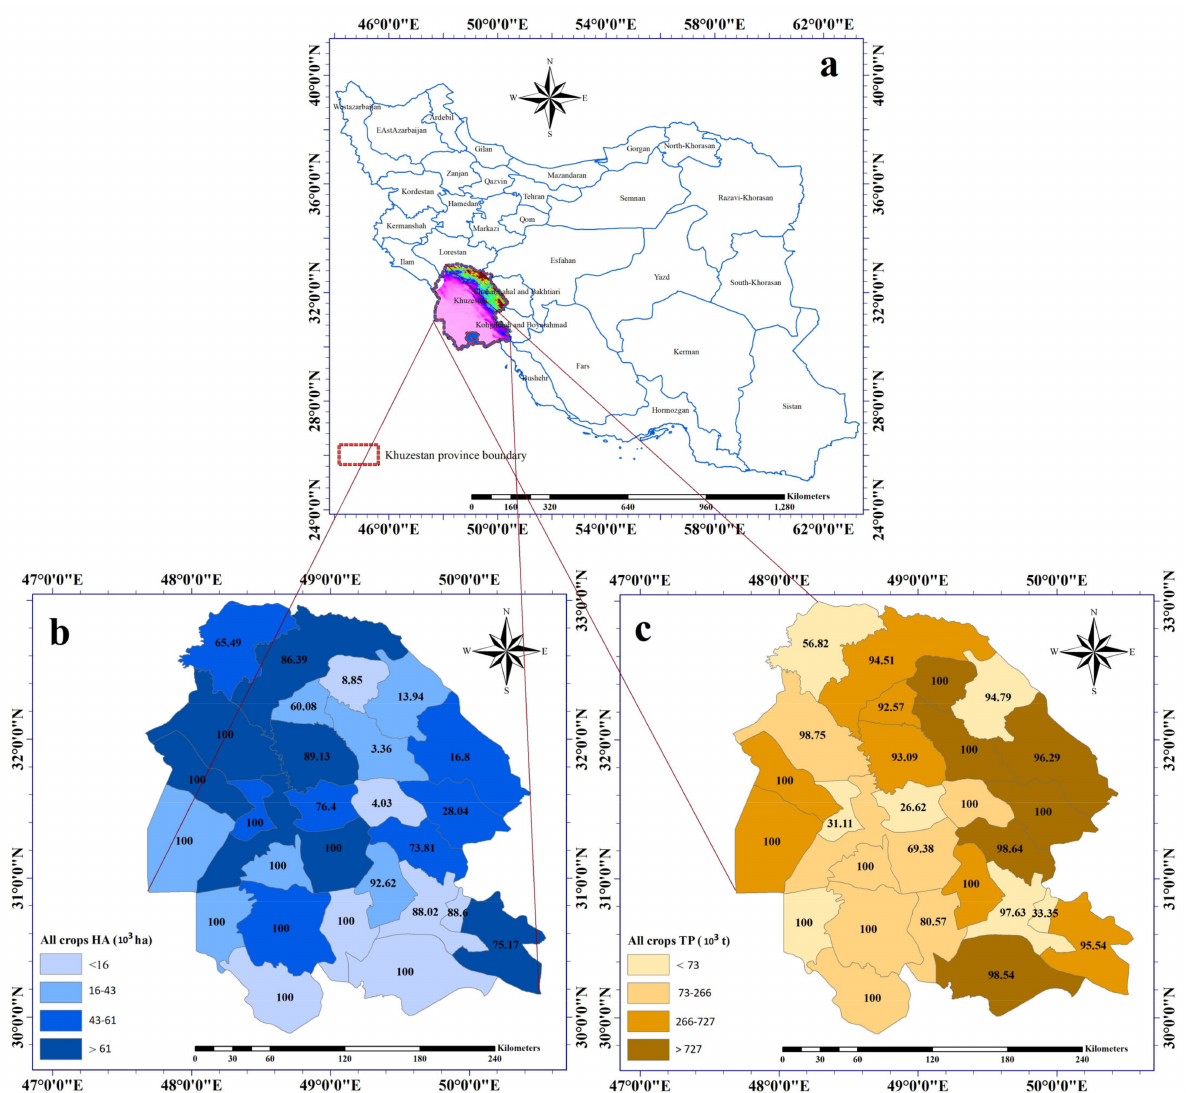
Figure 1. The location of Khuzestan province in Iran ( a ), and the contribution of different counties to total harvested area ( b ) and crop production ( c ) in the Khuzestan province. Numbers in the figures denotes the contribution of irrigated croplands/production in